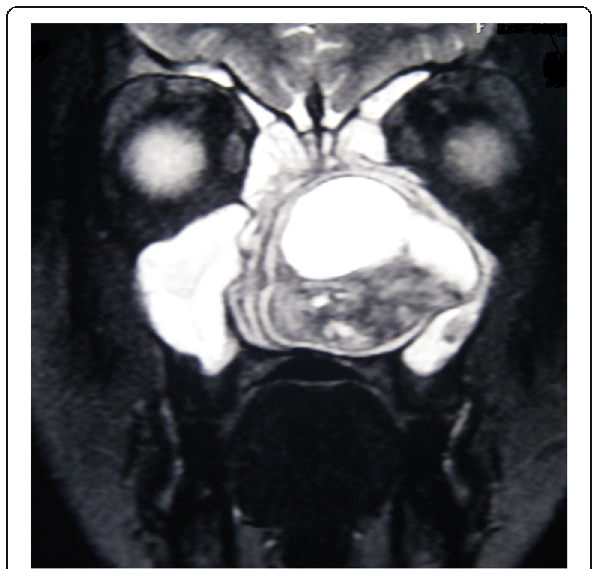
Fig. 2 Coronal MRI with contrast (T2 sequences) of the paranasal sinuses showing a huge lesion with mixed intensities of cystic and solid elements with clearly defined margins